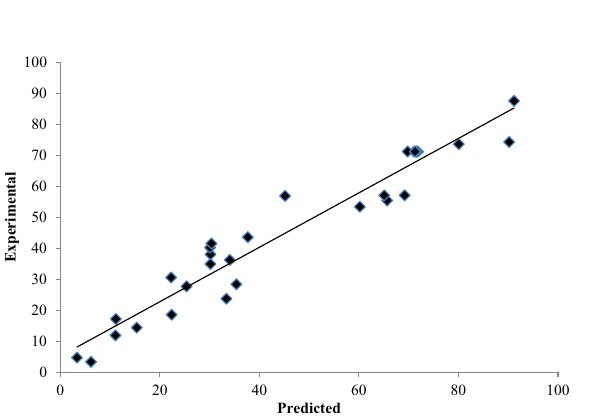
Figure 5. The predicted values plotted against actual values derived from CCD model for chlorpyrifos